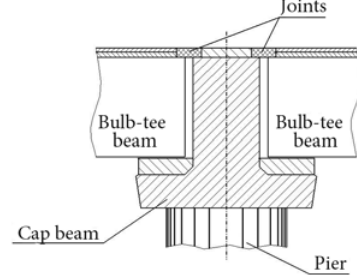
fig. 5. Support structure of the bridge